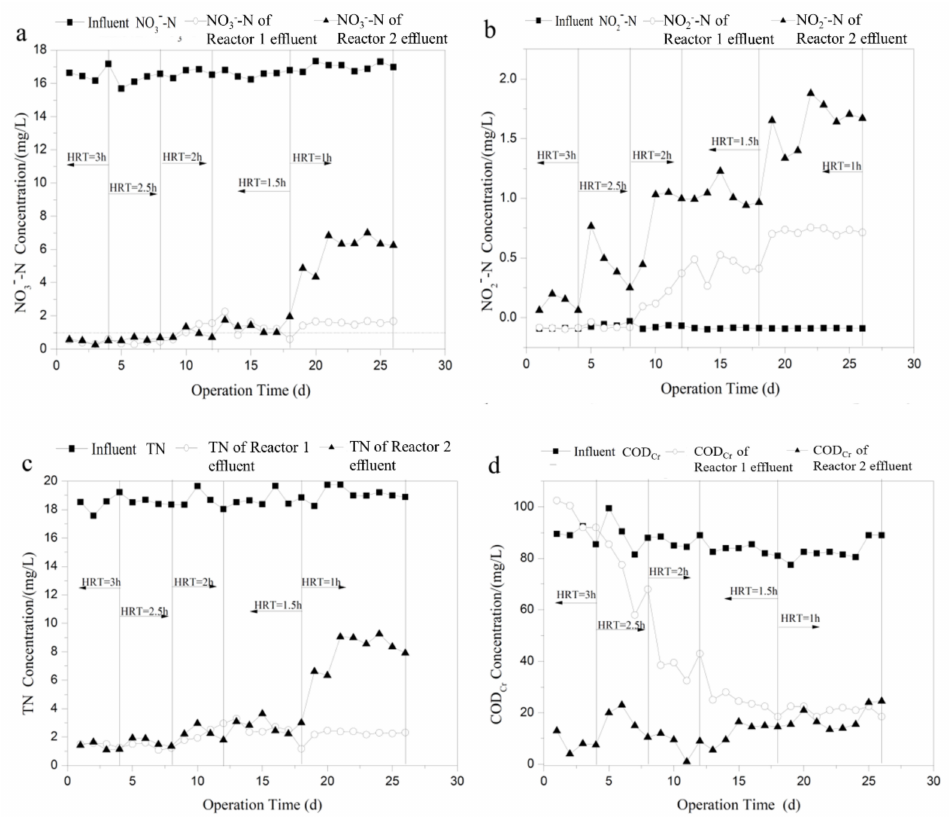
Figure 4. Influence of HRT on e ffl uent: ( a ) nitrate; ( b ) nitrite; ( c ) TN; and ( d ) COD Cr concentration